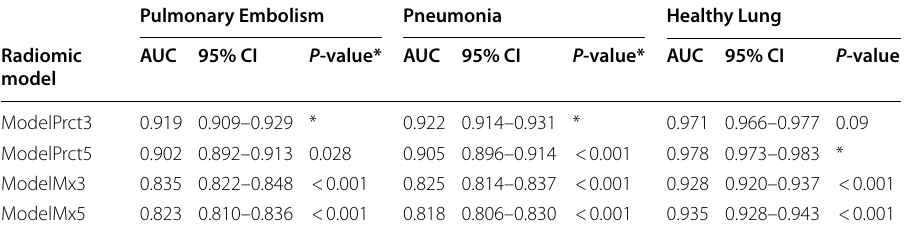
Table 4 AUC statistics for the leave‑1‑out training for model selection